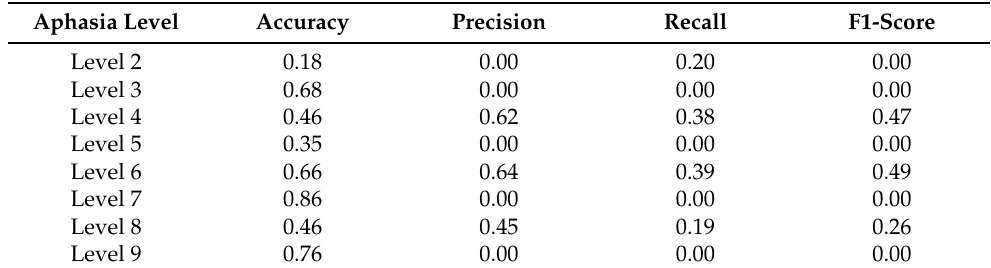
Table 16. Aphasia severity level classification report of decision tree machine learning model using 10 s audio chunks having features extracted using